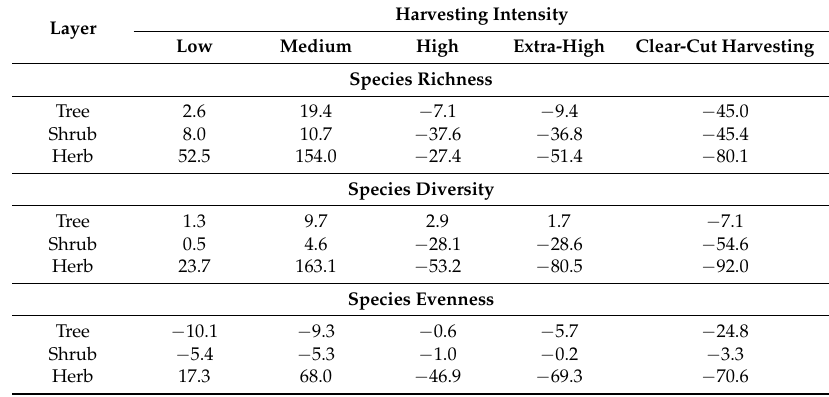
Table 5. Percentage changes in species diversity indices of various layers due to different harvesting intensities relative to